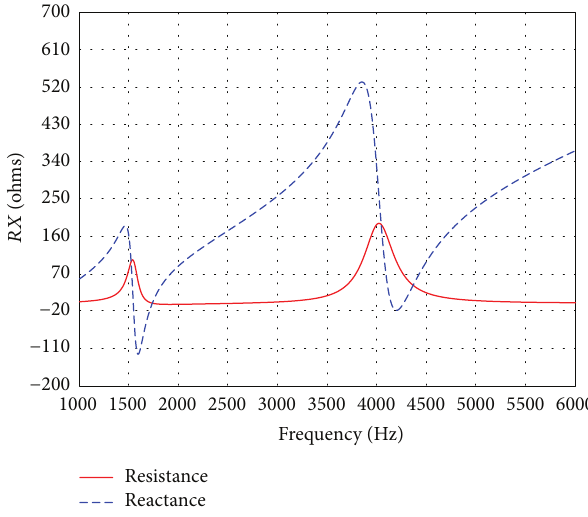
Figure 4: Impedance curves when only current drives in mag- netostrictive section (in water, obtained from equivalent circuit model).